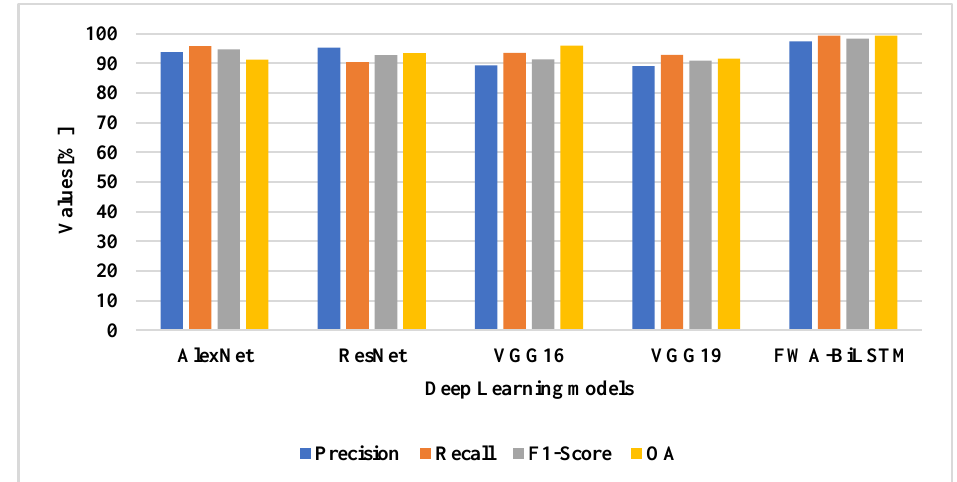
Figure 11. Deep learning techniques on SVD dataset.